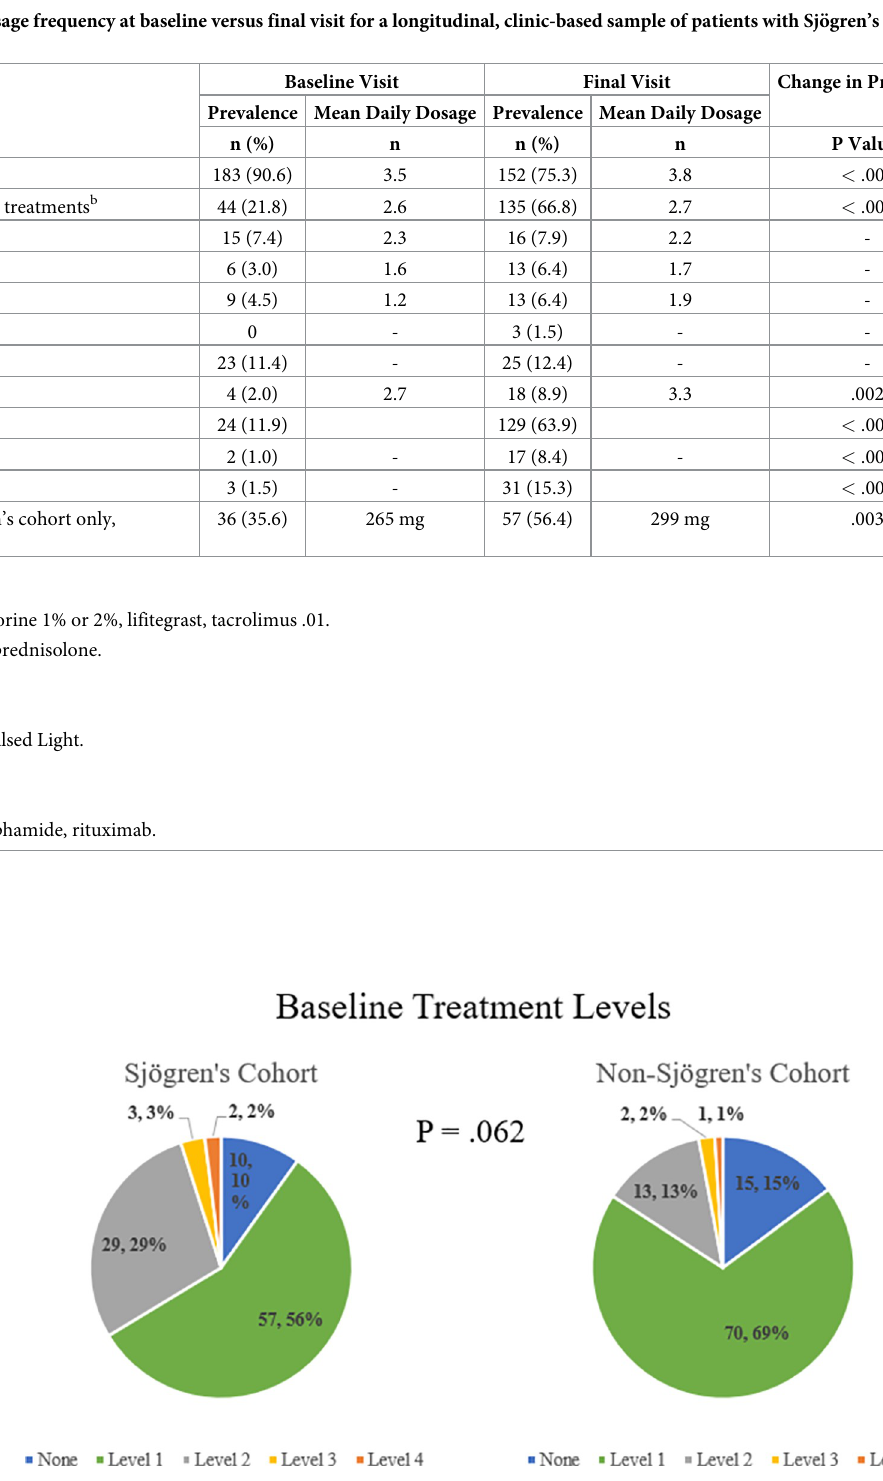
Fig 1. Baseline treatment levels according to tear film & ocular surface society treatment level classification for a longitudinal, tertiary clinic-based sample of patients with Sjogren’s and non-Sjogren’s dry eye disease (n =